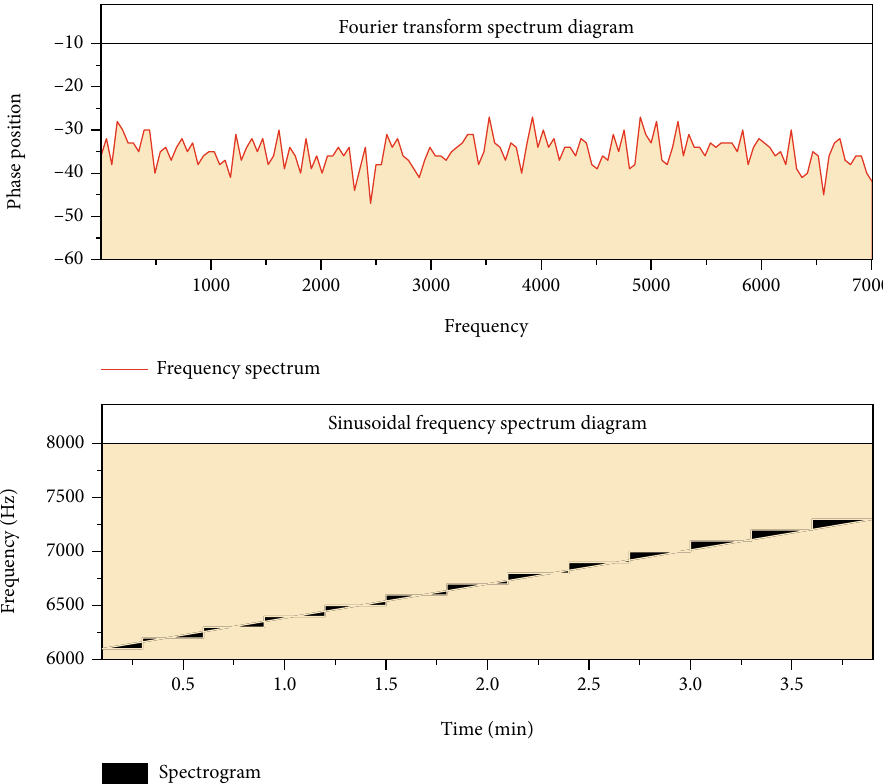
Figure 1: Spectrum diagram of the dispersion music